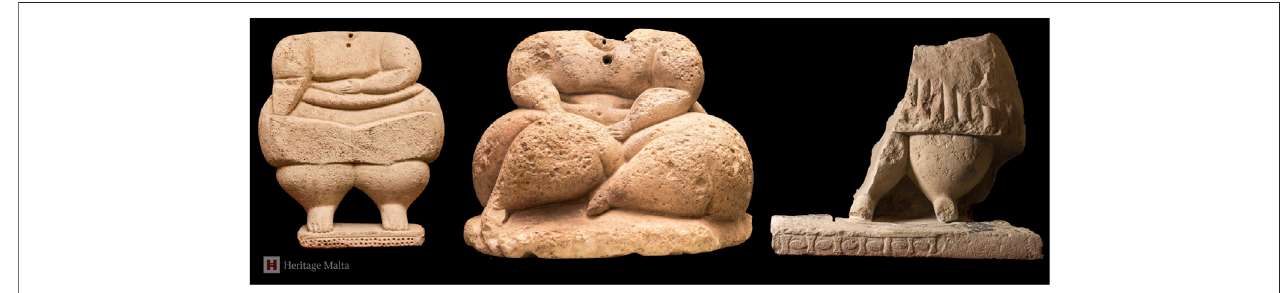
FIGURE 7 | Statues and fi gurines from Malta. Left and centre: fi gurines from Ħ a ġ ar Qim (48.6 and 23.5 cm high), Right: Broken giant statue from Tarxien (1.1 m high, the complete statue might have been nearly 3 m high when complete). (All photos courtesy of Heritage Malta. Copyright images not to be reused without permission of Heritage